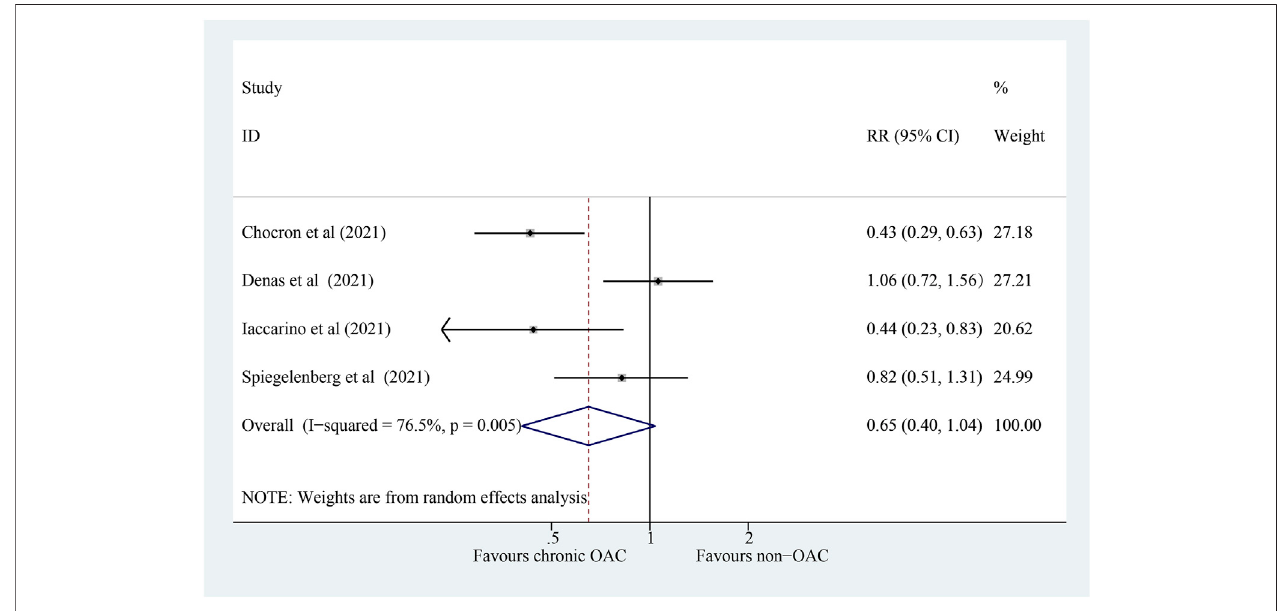
FIGURE 4 | Forest plot for the association of chronic OAC with ICU admission in COVID-19 patients, random model. OAC, oral anticoagulation; COVID-19, coronavirus disease 2019; RR, relative risk; CI, con fi dence interval; ICU, intensive care unit; P , heterogeneity test.